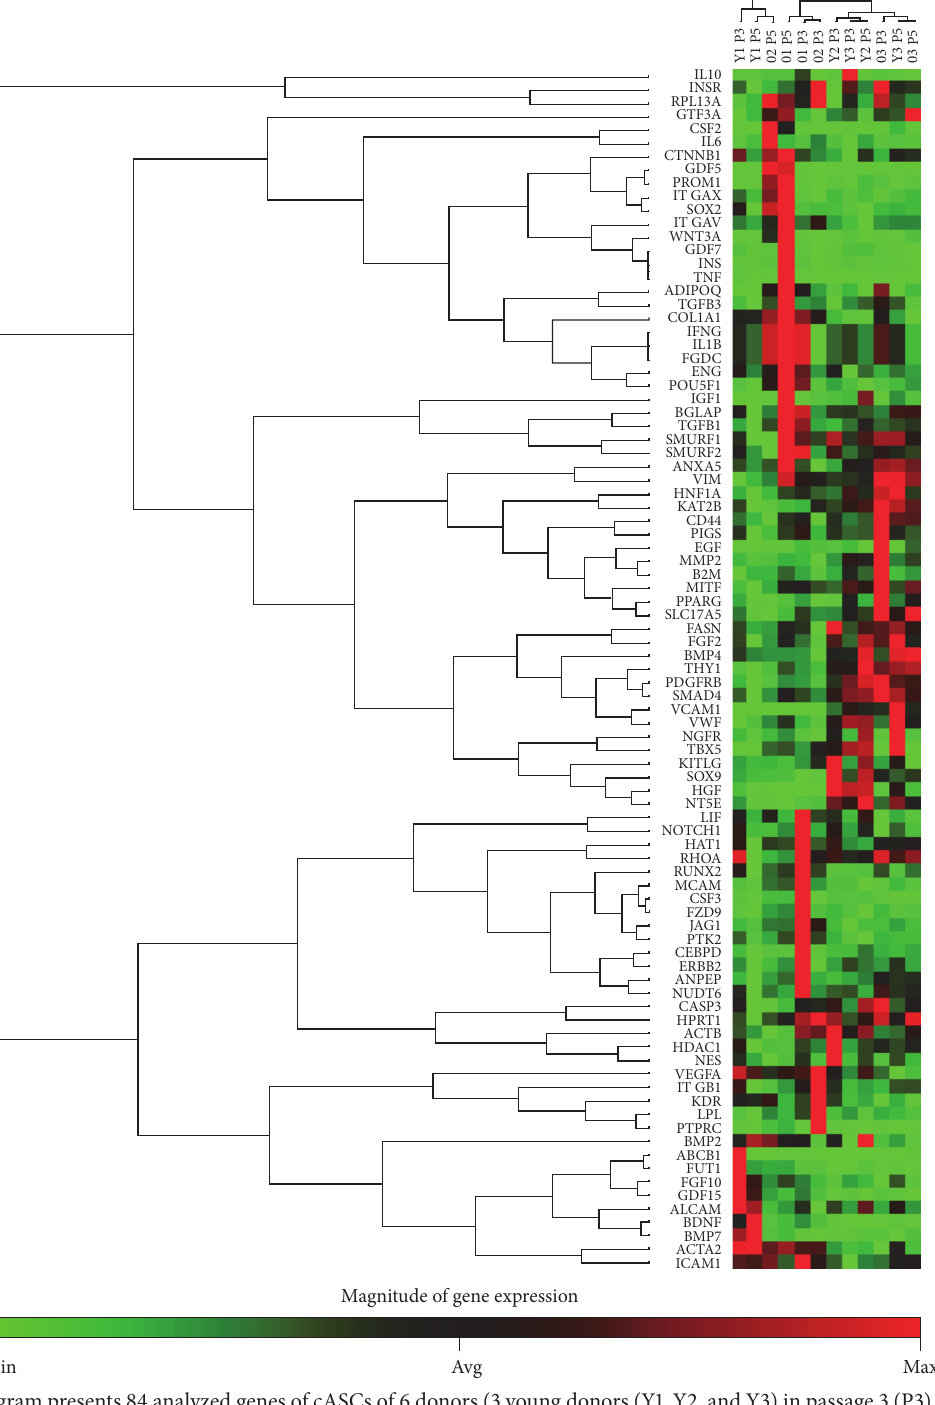
Figure 5: Clustergram presents 84 analyzed genes of cASCs of 6 donors (3 young donors (Y1, Y2, and Y3) in passage 3 (P3) and P5 and 3 old donors (O1, O2, and O3) in P3 and P5). Passage 3 of cASCs was used as control group and P5 of cASCs represents test group. Nonsupervised hierarchical clustering of the entire dataset displayed no age or passage number related clustering.